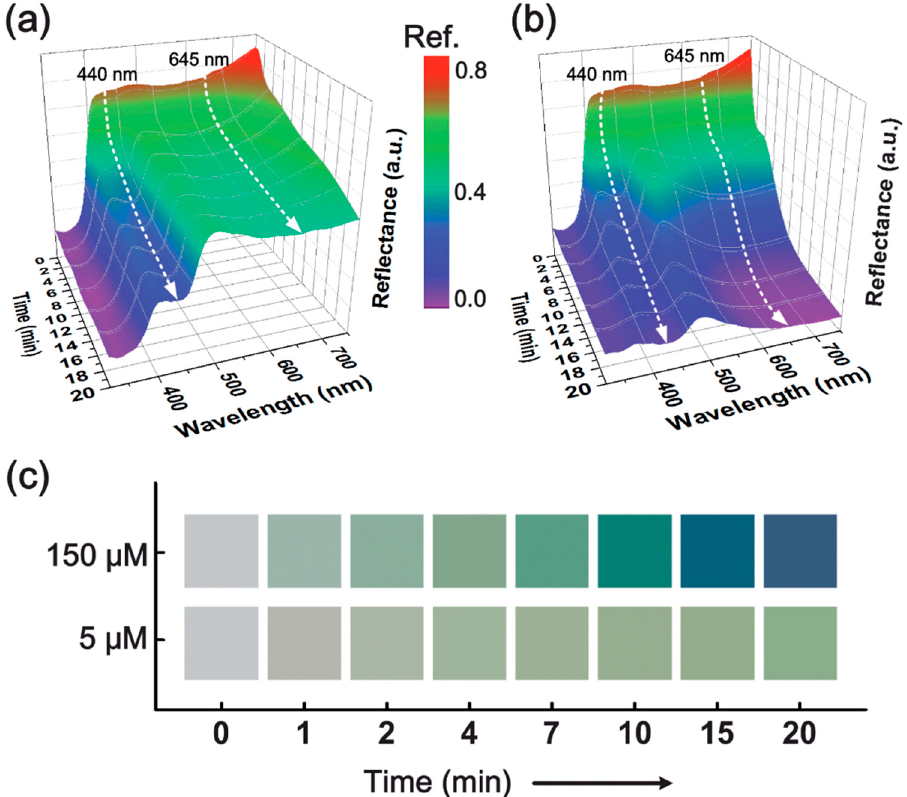
Figure 3. Kinetic reflectance response of the polyaniline-leucoemeraldine base nanofiber (PANI-LBNF) sensor strips as a function of time for different Hg 2+ concentrations: ( a ) 5 μ M and ( b ) 150 μ M. ( c ) The corresponding time-dependent visualization of CIELAB color changes versus Hg 2+ concentration. Reprinted with permission from [40]. Copyright 2014, The Royal Society of Chemistry.